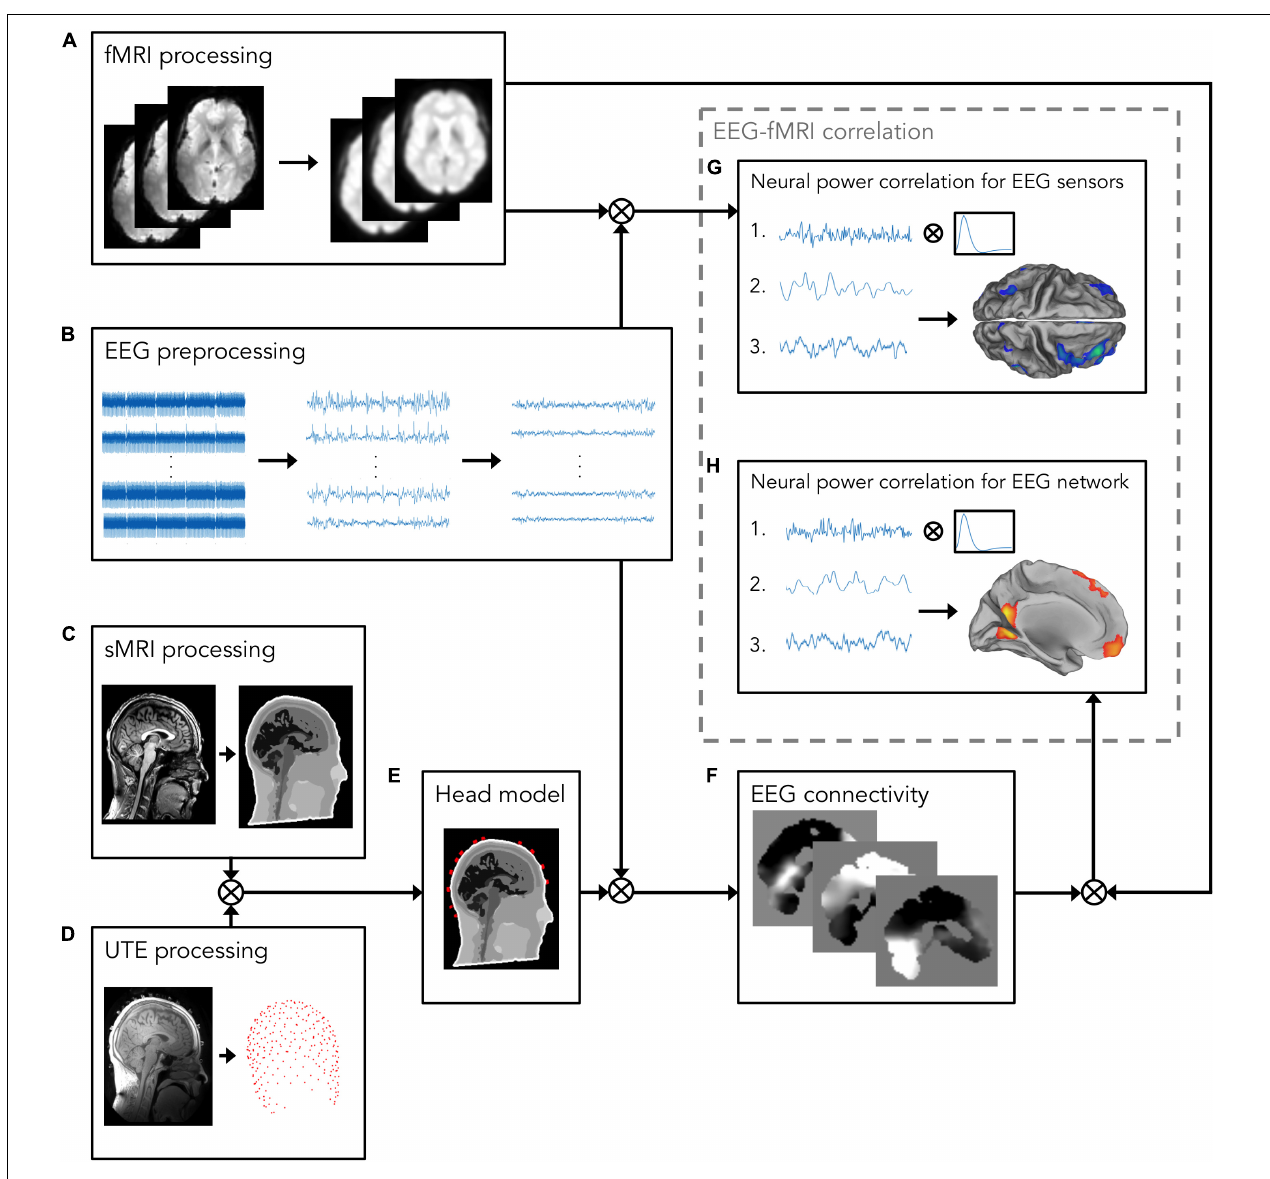
FIGURE 1 | Analysis workflow for investigating the relationship between EEG and fMRI measurements. The workflow consists of the following processing steps: (A) fMRI processing, including motion correction, spatial alignment to sMRI, bias field correction, co-registration to standard space, and spatial smoothing. The resulting fMRI signals will be used for the EEG–fMRI correlation analysis; (B) EEG preprocessing, including removal of MR-related artifacts, i.e., gradient artifact, displayed on the left, and BCG, displayed in the middle, and removal of other biological artifacts, e.g., EOG, and EMG. On the right, artifacts-free EEG recordings are shown; (C) sMRI processing, including INU correction and image segmentation in 12 head tissues; (D) UTE processing for detecting EEG electrode positions; (E) Head model, generated by integrating the information about EEG electrode positions and segmented sMR image, in which electrical properties are assigned to each head tissue. Following source reconstruction, in which cleaned EEG data are combined with the realistic head model, (F) EEG connectivity analysis is performed. To this end, the power in alpha band is calculated from source-reconstructed EEG signals. Then, power signals are given in input to an ICA algorithm for separating patterns, each consisting of a spatial map and a time-course, of coordinated activity in the brain and artifactual sources. From these patterns, the one associated with the DMN is automatically selected using a template-matching procedure; (G,H) EEG–fMRI correlation analysis; (G) The power in alpha band from occipital channels (1) is calculated from artifact-free EEG recordings obtained in panel (B) , and, after convolving it with a canonical HRF (2), it is correlated with the fMRI signals processed in panel (A) (3); (H) the DMN time-course (1), calculated in panel (F) , is convolved with a canonical HRF (2), and correlated with the fMRI signals processed in panel (A)